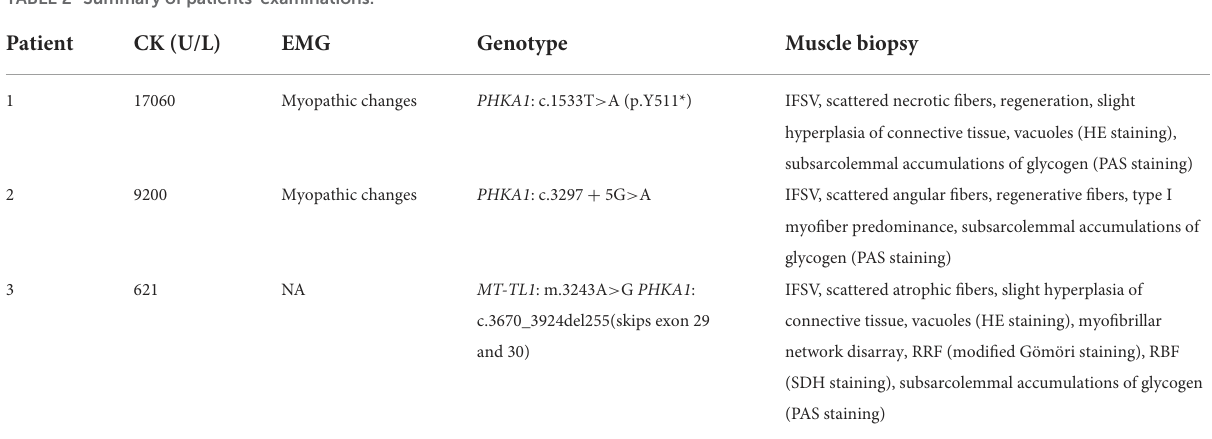
TABLE 2 Summary of patients’